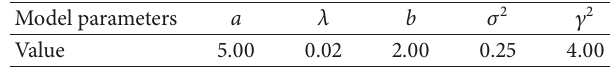
Table 2: Parameters of the simulated degradation path.